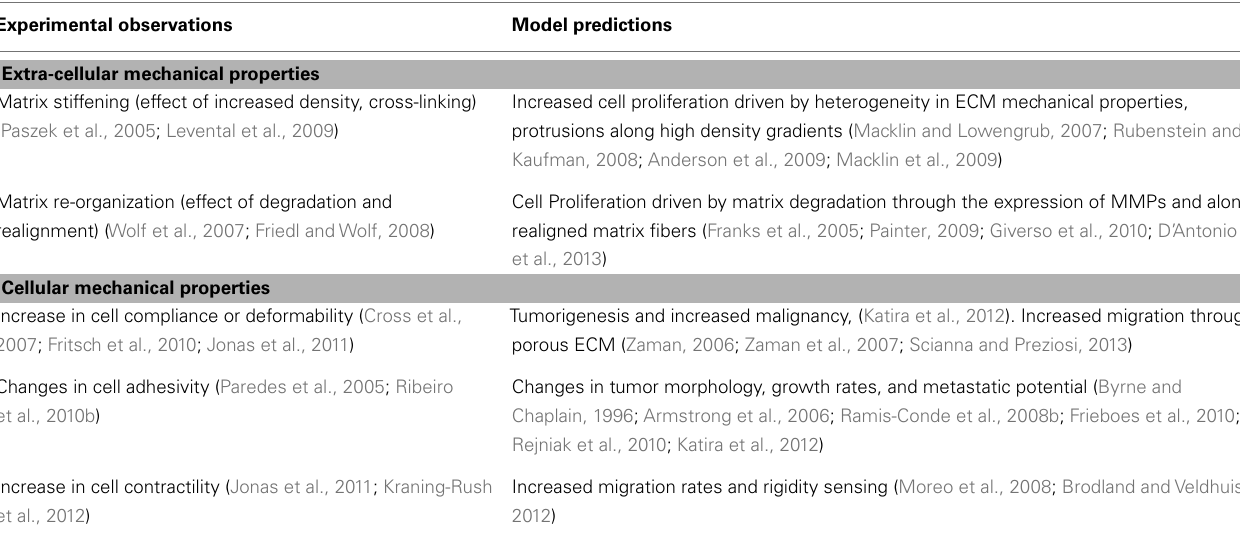
Table 1 | Some specific changes in cellular and extra-cellular mechanical properties, observations from experiments and computational